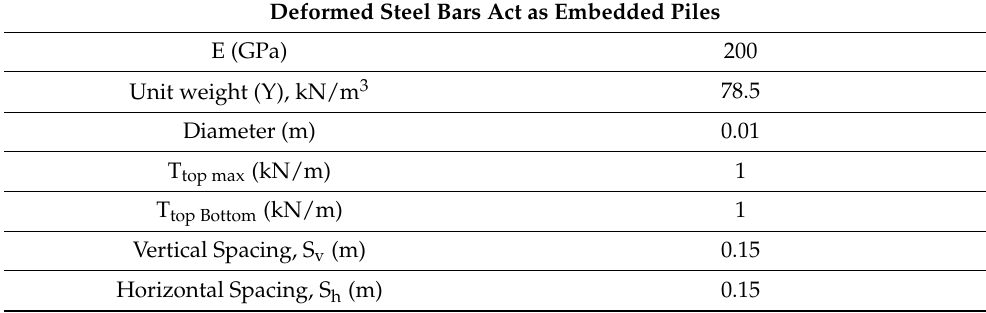
Table 1. Properties of material and specifications.